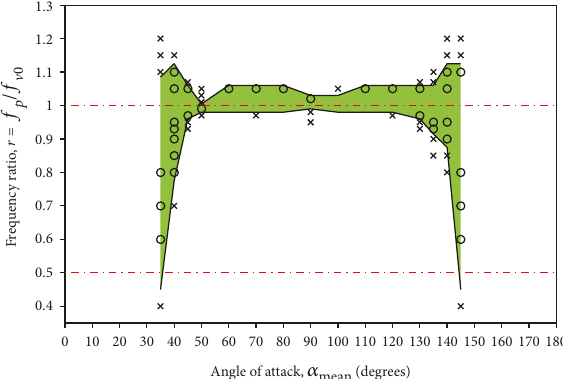
Figure 5: Lock-in map for positive angles of attack, pitching motion at α = 7 ° : ○ , lock-in; × , lock-out and lock-in region (in ampl